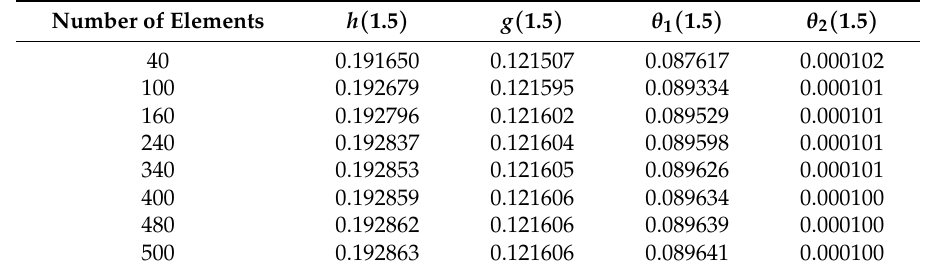
Table 2. FEM convergence results of h ( η ) , g ( η ) , θ 1 ( η ) , and θ 2 ( η ) for different numbers of